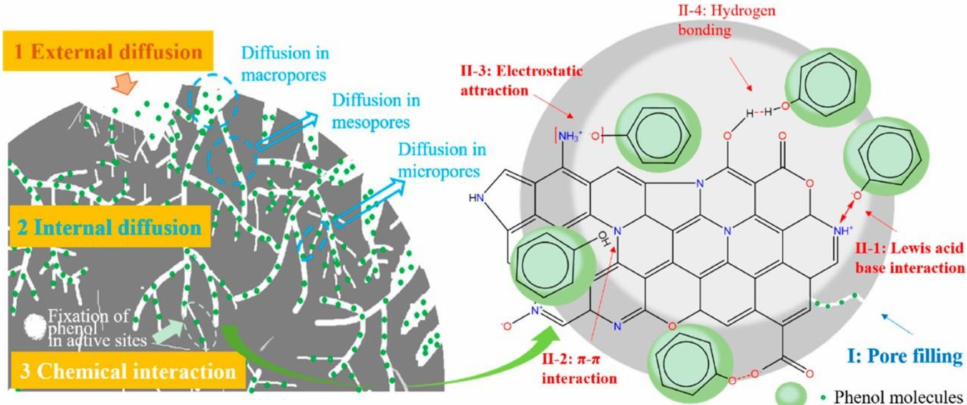
Figure 1. Mechanism of phenol adsorption by N-doped biochar. Reprinted with permission from Li et al. [14]. Copyright 2019 American Chemical